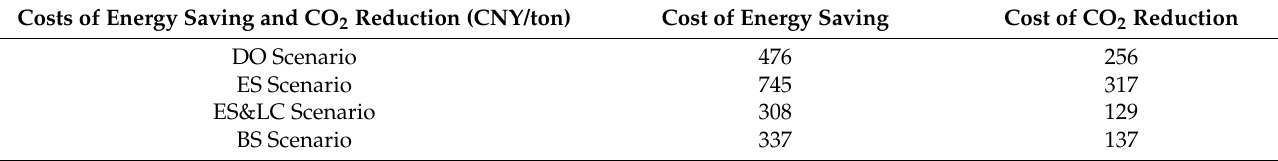
Table 6. Technical improvement costs of unit carbon reduction in main scenarios.